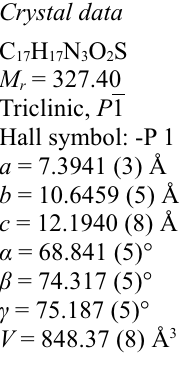
Figure 3 The reaction scheme. 3-(3-Methoxybenzyl)-4-(2-methoxyphenyl)-1 H -1,2,4-triazole-5(4 H )-